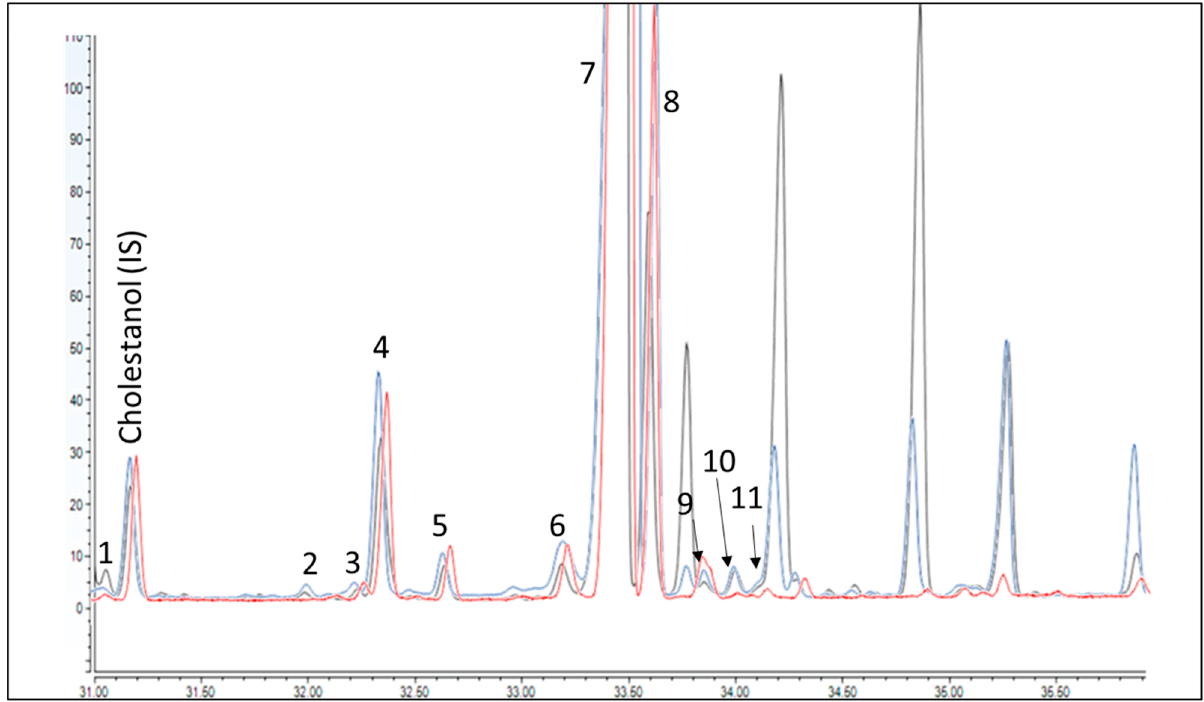
Figure 2. GC-FID trace chromatogram of the sterol fraction obtained using the IOC method (red trace), the first optimized method where the sterol fraction was eluted after 5 mL of hexane/Et 2 O (88/12, v / v ) (black trace) and the final conditions (blue trace). Identification as for Table 1.